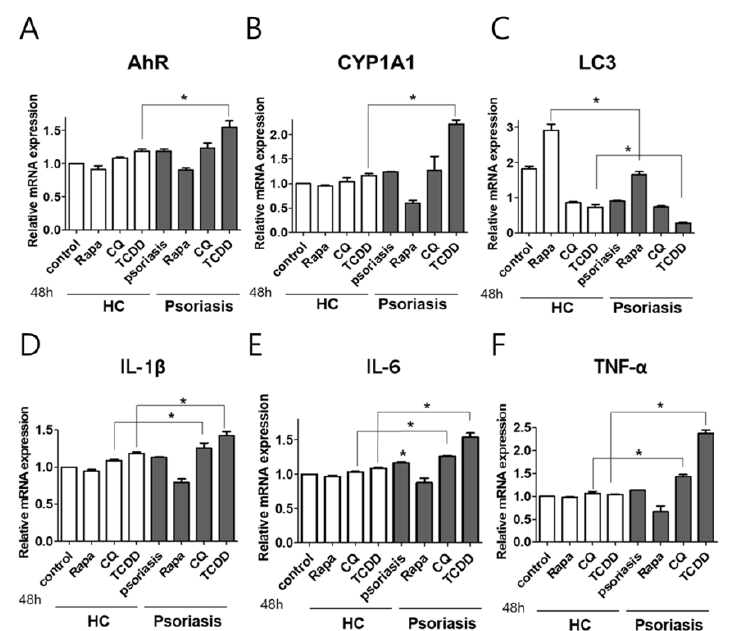
Figure 9. The e ff ects of AhR or autophagy modulation on the expression of AhR, CYP1A1, LC3, and proinflammatory cytokines in human psoriasis skin biopsies. Human skin explants were treated with rapamycin, chloroquine, or TCDD, and cultured for 48 h before mRNA quantification. qPCR analysis was then performed to determine ( A ) AHR, ( B ) CYP1A1, ( C ) LC3, ( D ) IL-1 β , ( E ) IL-6, and ( F ) TNF- α expression in human psoriasis skin biopsies ( n = 3) and healthy control (HC) tissues ( n = 3). Data represent the mean ± S.D. of three independent experiments (each performed in duplicate). Statistical analysis was performed by one-way ANOVA test followed by multiple comparison Tukey’s test. * indicates p < 0.05 in comparison to unstimulated cells. Rapa, rapamycin, CQ, chloroquine.